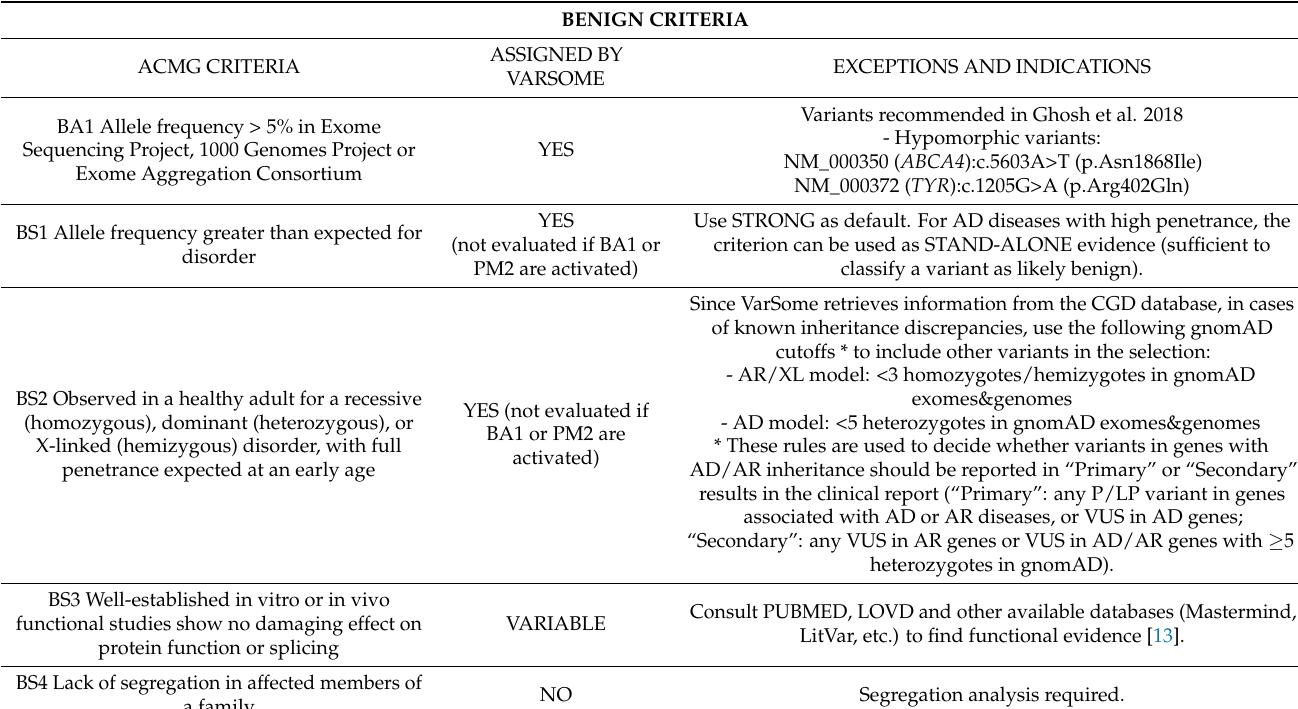
Table 2. Combination of criteria for variant interpretation according to ACMG-AMP guidelines and modifications imple- mented in the internal ACMG-based